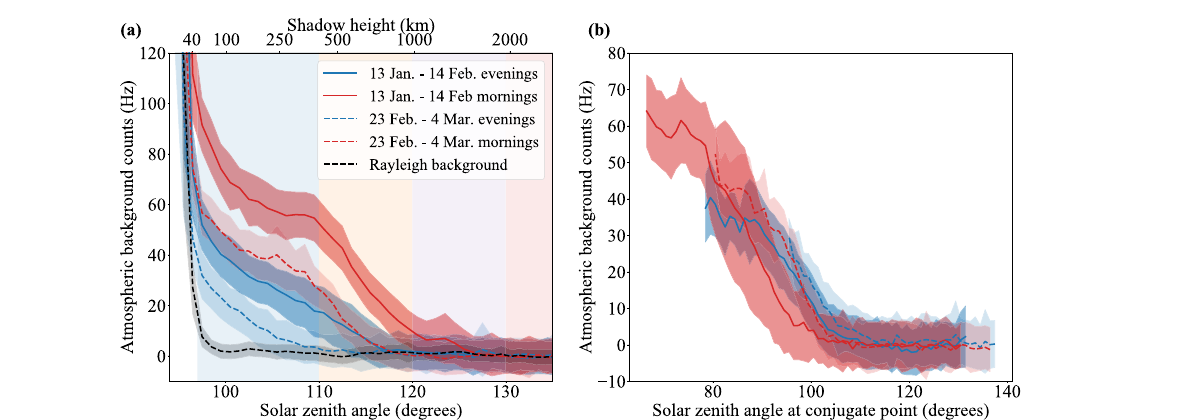
Fig. 2 | Active He(2 3 S) measurements. Evening ( a , c ) and morning ( b , d ) He(2 3 S) densitypro fi lesmeasuredoversixnightsbetweenJanuary13andFebruary14,2022 ( a , b ) and fi ve nights between February 23 and March 4, 2022 ( c , d ). The data are binned andplotted accordingto solarzenithangle(see legend).Notethatthe data